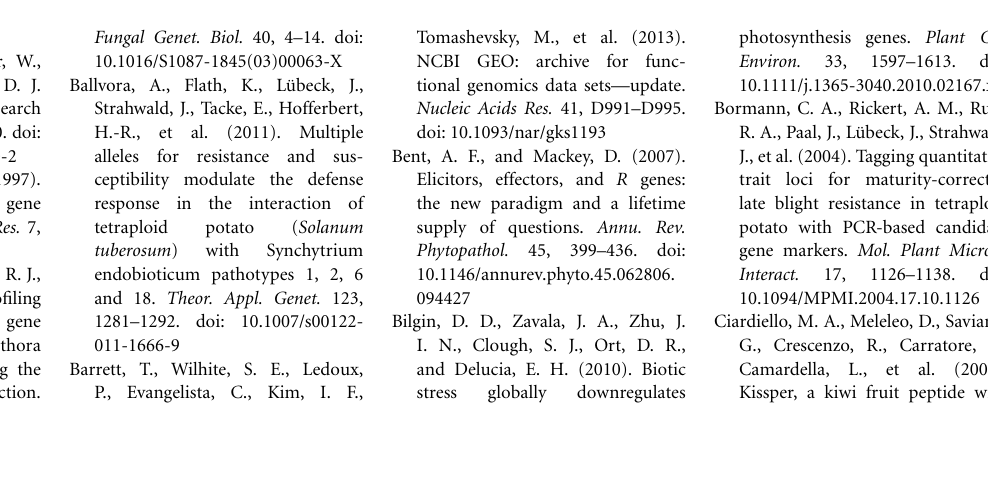
Supplementary Table S5 | Phytophthora infestans tags. (Sheet 5). Supplementary Table S6 | StAOS2 tags. (Sheet 6). Supplementary Table S7 | Tag counts different specifically between pools A2 and B2. Higher expression in pool A2 vs. B2 is highlighted green in column J, opposite expression differences at different time points are highlighted orange. (Sheet 7). Supplementary Table S8 | Transcripts differential in response to infection with P. infestans . Down regulated transcripts are highlighted yellow in columns K and L. (Sheet 8). Supplementary Table S9 | “No hit” tags differential in response to infection with P. infestans . Down regulated tags are highlighted yellow in columns K and L. (Sheet 9). Supplementary Table S10 | Transcripts differential between genotype pools. Transcripts showing the MCR conform expression pattern at all time points are highlighted green in columns M to R. (Sheet 10). Supplementary Table S11 | “No hit” tags differential between genotype pools. Tags showing the MCR conform expression pattern at all time points are highlighted green in columnsM to R. (Sheet 11). Supplementary Table S12 | Transcripts and “no hit” tags differential in response to infection and between genotype pools. (Sheet